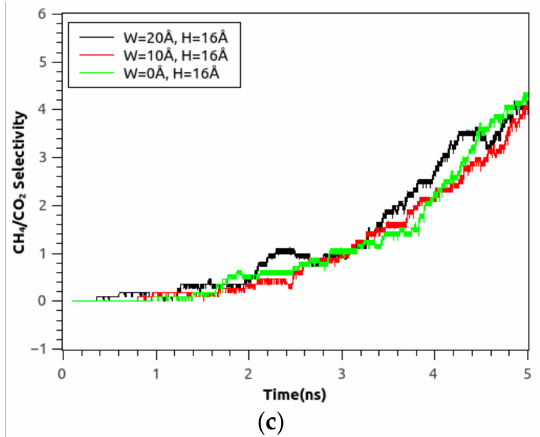
Figure 8. The effect of interlayer spacing on the instantaneous CH 4 /CO 2 selectivity as a function of simulation time ( a ) H = 8 Å ( b ) H = 12 Å ( c ) H = 16